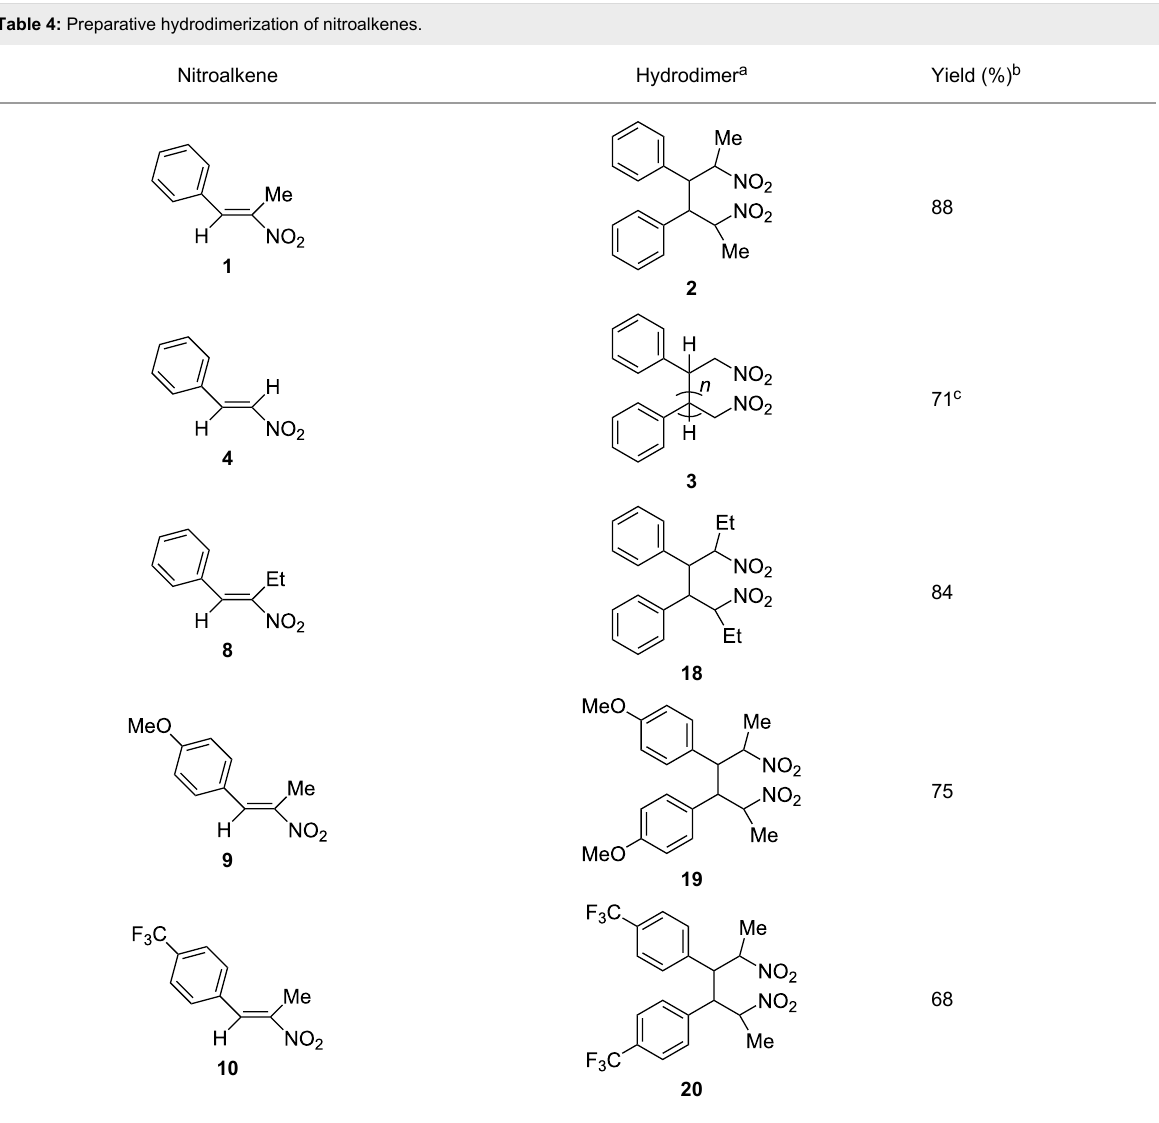
Table 4: Preparative hydrodimerization of